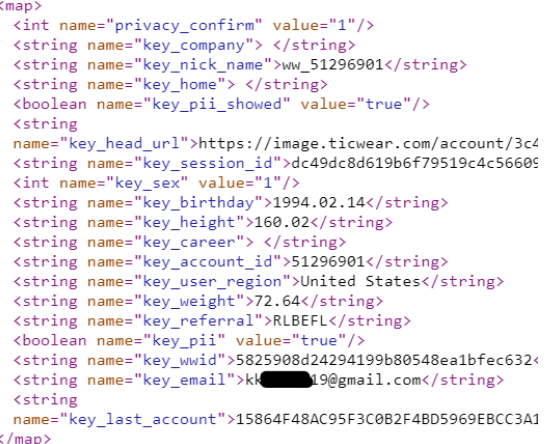
Figure 24. A redacted view of the TicWatch’s user account